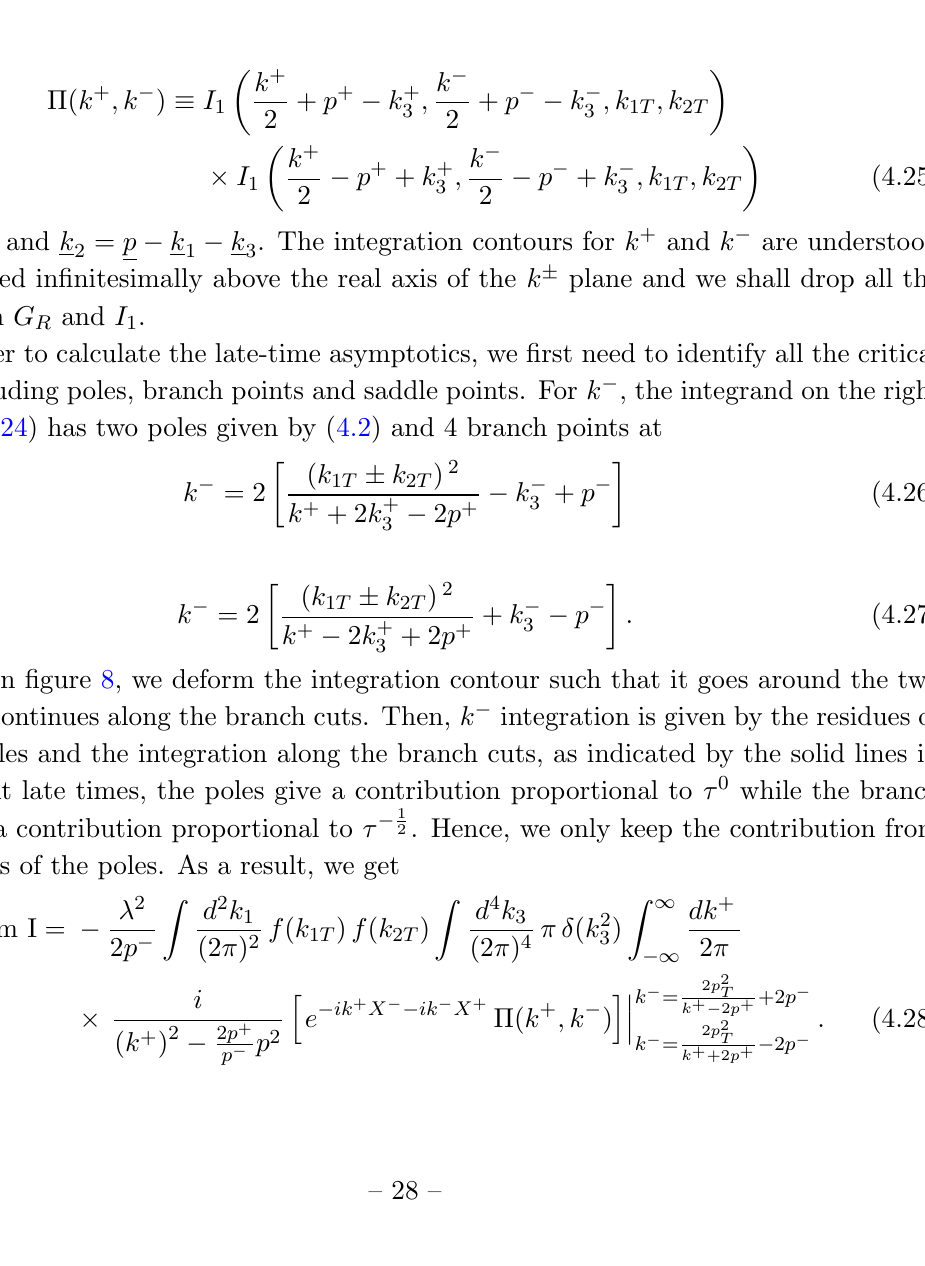
Figure 8 . Integration contour for k (cid:0) . In the integration over k (cid:0) in (4.24), the integration contour is deformed in order to pick up the predominant contribution at late times from the regions around singular points (poles and branch points). The portions of the contour giving vanishing or canceling contributions are indicated by the dashed